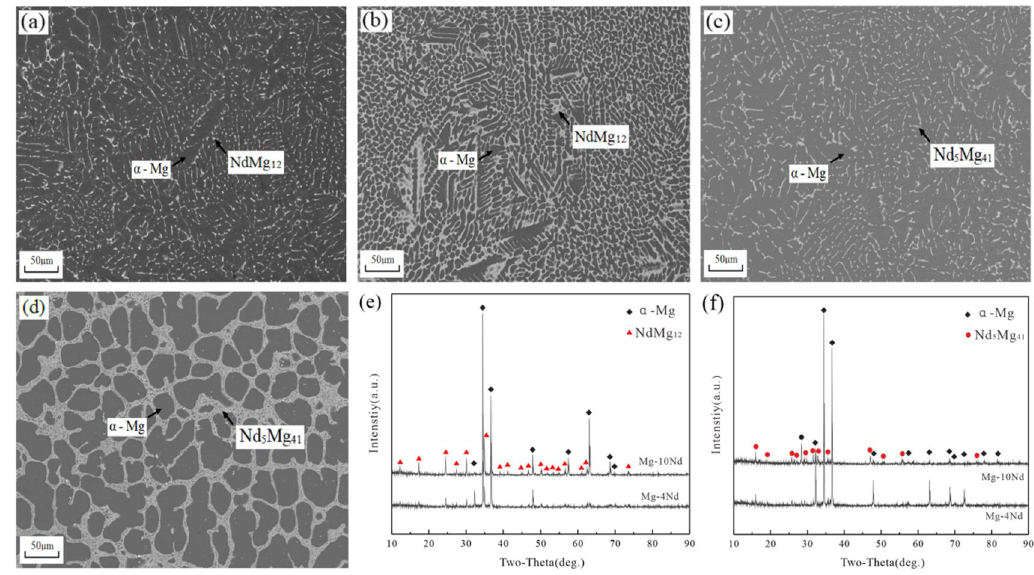
Figure 6. BSE micrographs of ( a ) the as-cast Mg-4Nd alloy, ( b ) the as-cast Mg-10Nd alloy, ( c ) the annealed Mg-4Nd alloy, and ( d ) the annealed Mg-10Nd alloy; and XRD diffraction patterns of ( e ) the as-cast Mg-4Nd and Mg-10Nd alloys, and ( f ) the annealed Mg-4Nd and Mg-10Nd alloys.